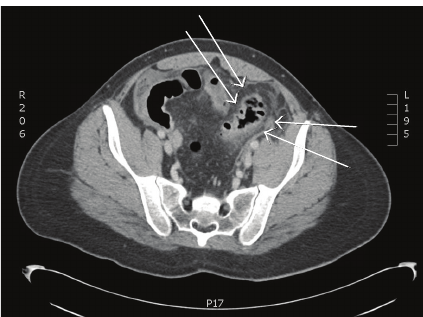
Figure 1: Wall thickening and inflammatory changes involving the sigmoid colon with multifocal pneumoperitoneum. Scattered hypodense collections in the abdomen and pelvis without obvious well-defined, rim-enhancing